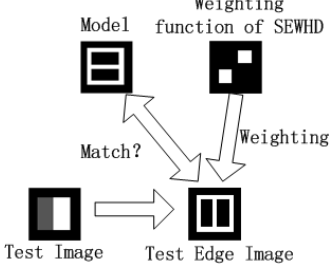
Fig. 2 Example of wrong matching using